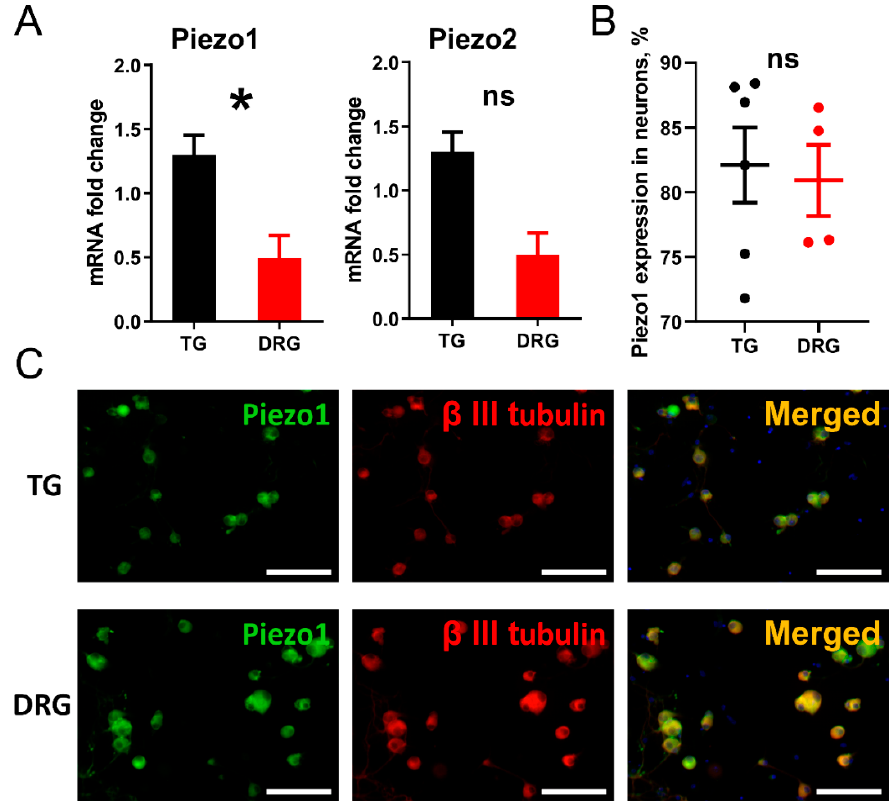
Figure 5. ( A ) Expression of Piezo1 and Piezo2- coding mRNA in TG vs. DRG cells. Data is normalized against 18S mRNA level. * p < 0.05 by paired Student’s t -test ( n = 3 biological replicates, data presented as mean ± SEM). ( B ) Expression rate of Piezo1 protein in TG vs. DRG neurons (co-expression with β III tubulin), data presented as mean ± SEM. ( C ) Immunocytochemical staining of Piezo1 (green) and β III tubulin (red) in TG vs. DRG neurons. Blue colour—DAPI. Scale bars—100 μ m. Next, we conducted immunocytochemical staining of Piezo1 protein in TG vs. DRG cells (Figure 5B,C). The cells were also stained for β III tubulin as a neuronal marker. In